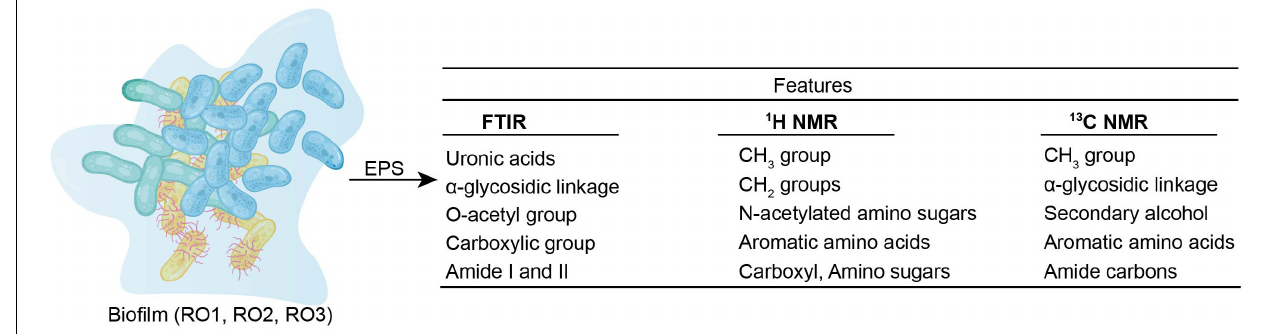
EPS Carbohydrates Are Mainly Linked by α -Glycosidic